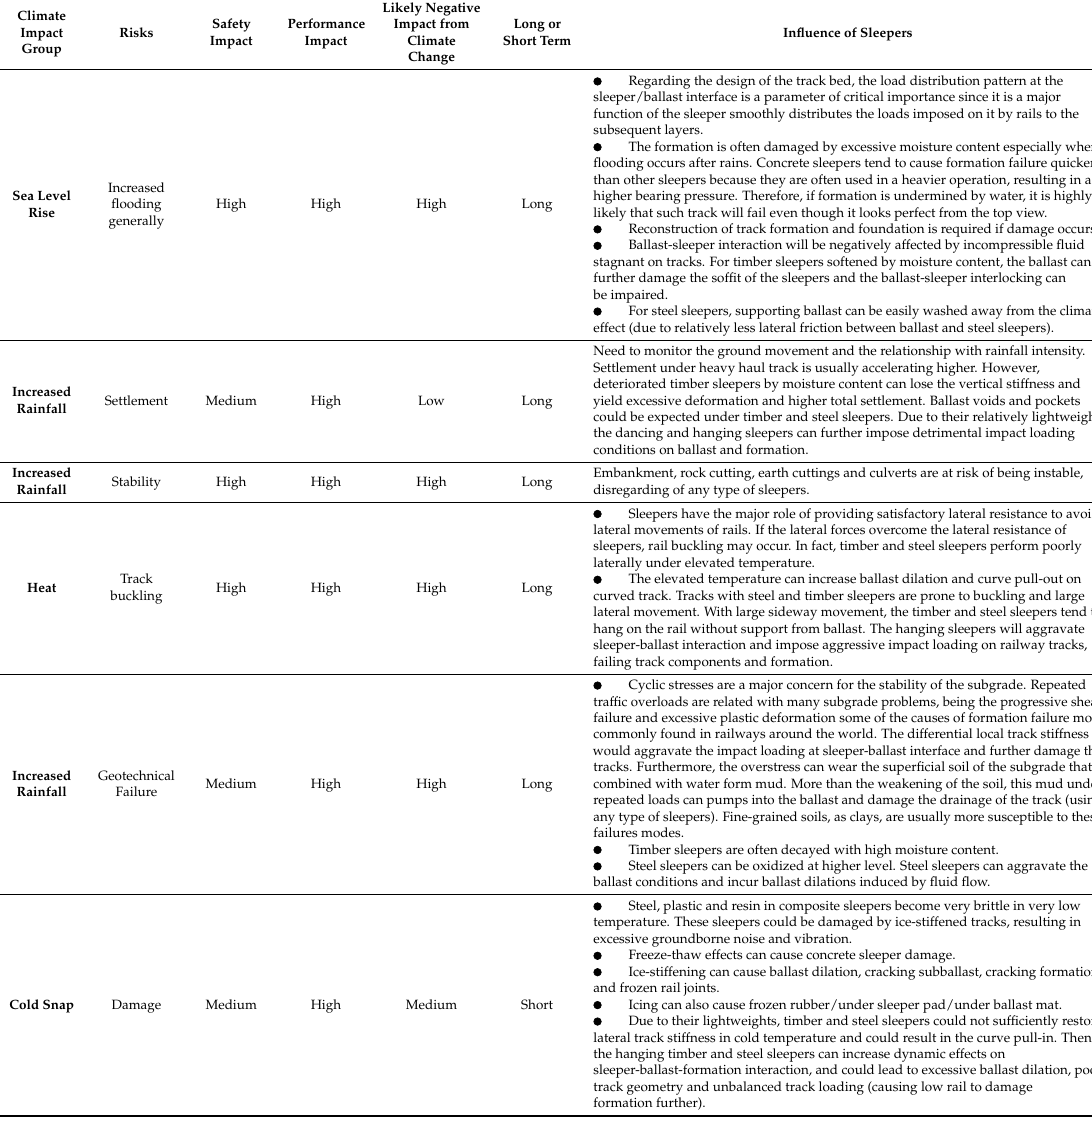
Table 6. Georisks of rail infrastructure due to sleeper